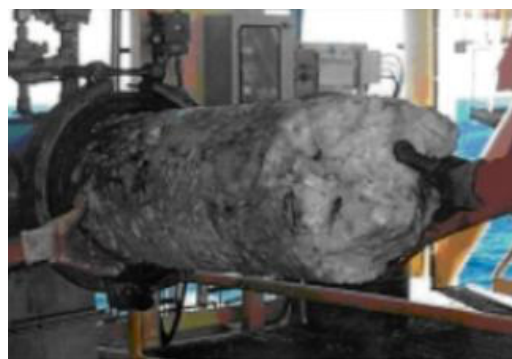
Figure 1—Hydrate.